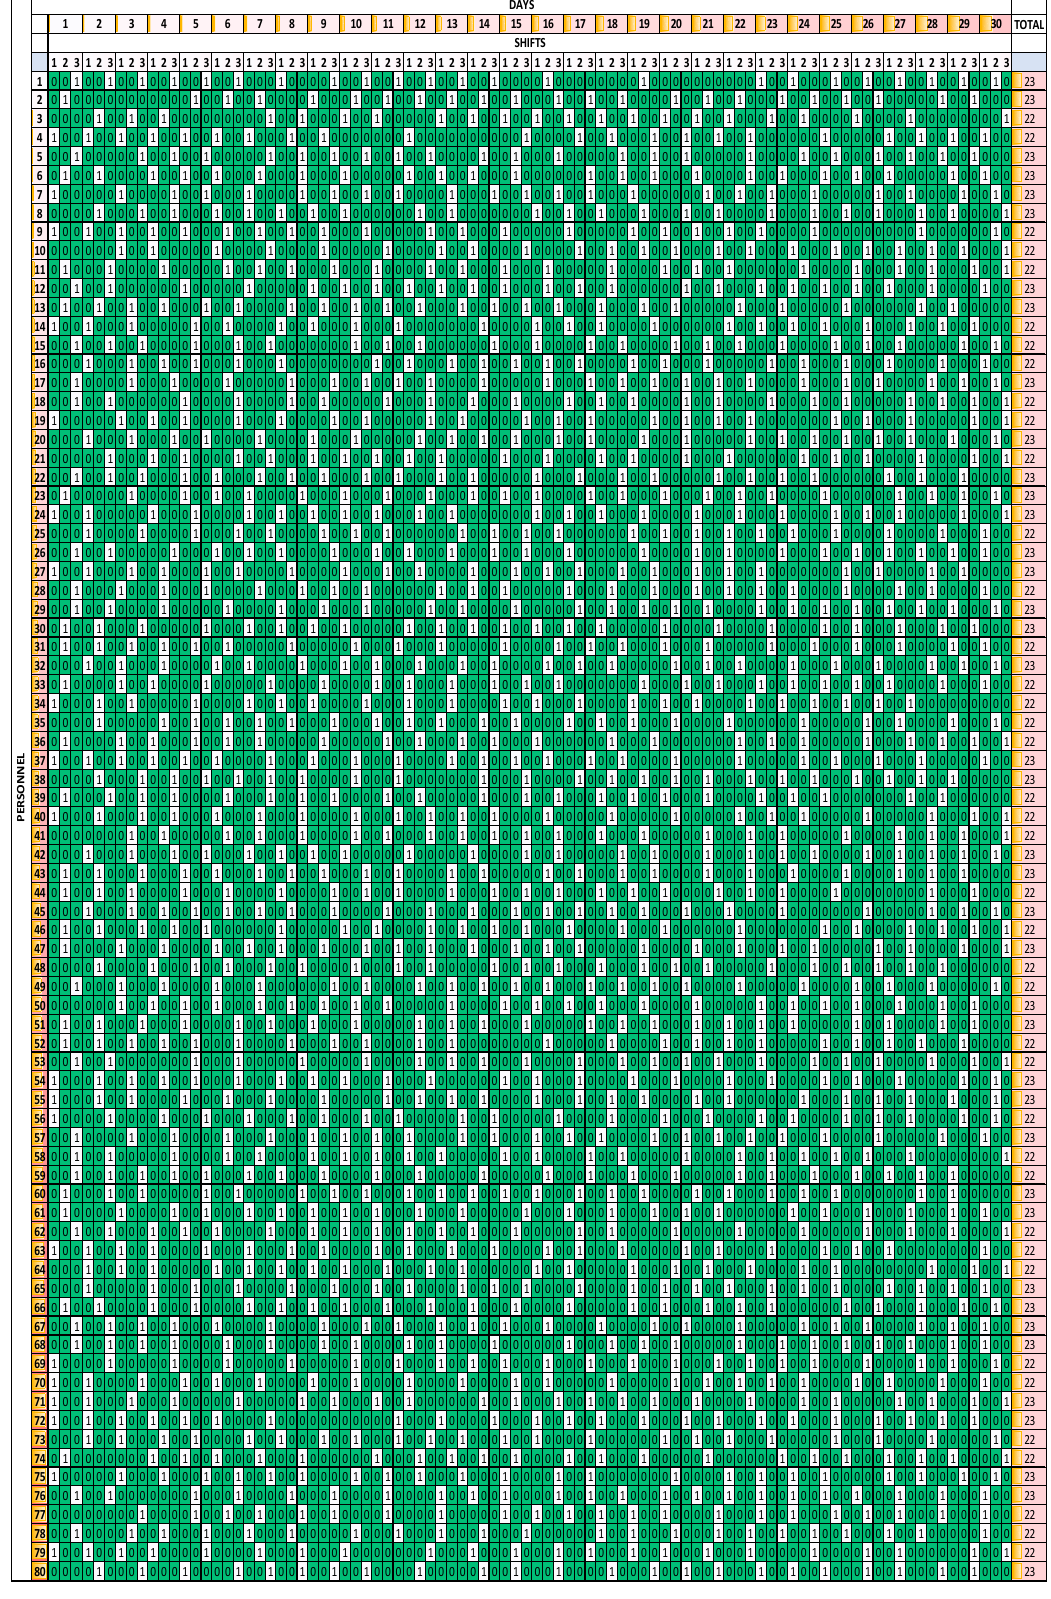
Figure 3. The final schedule.